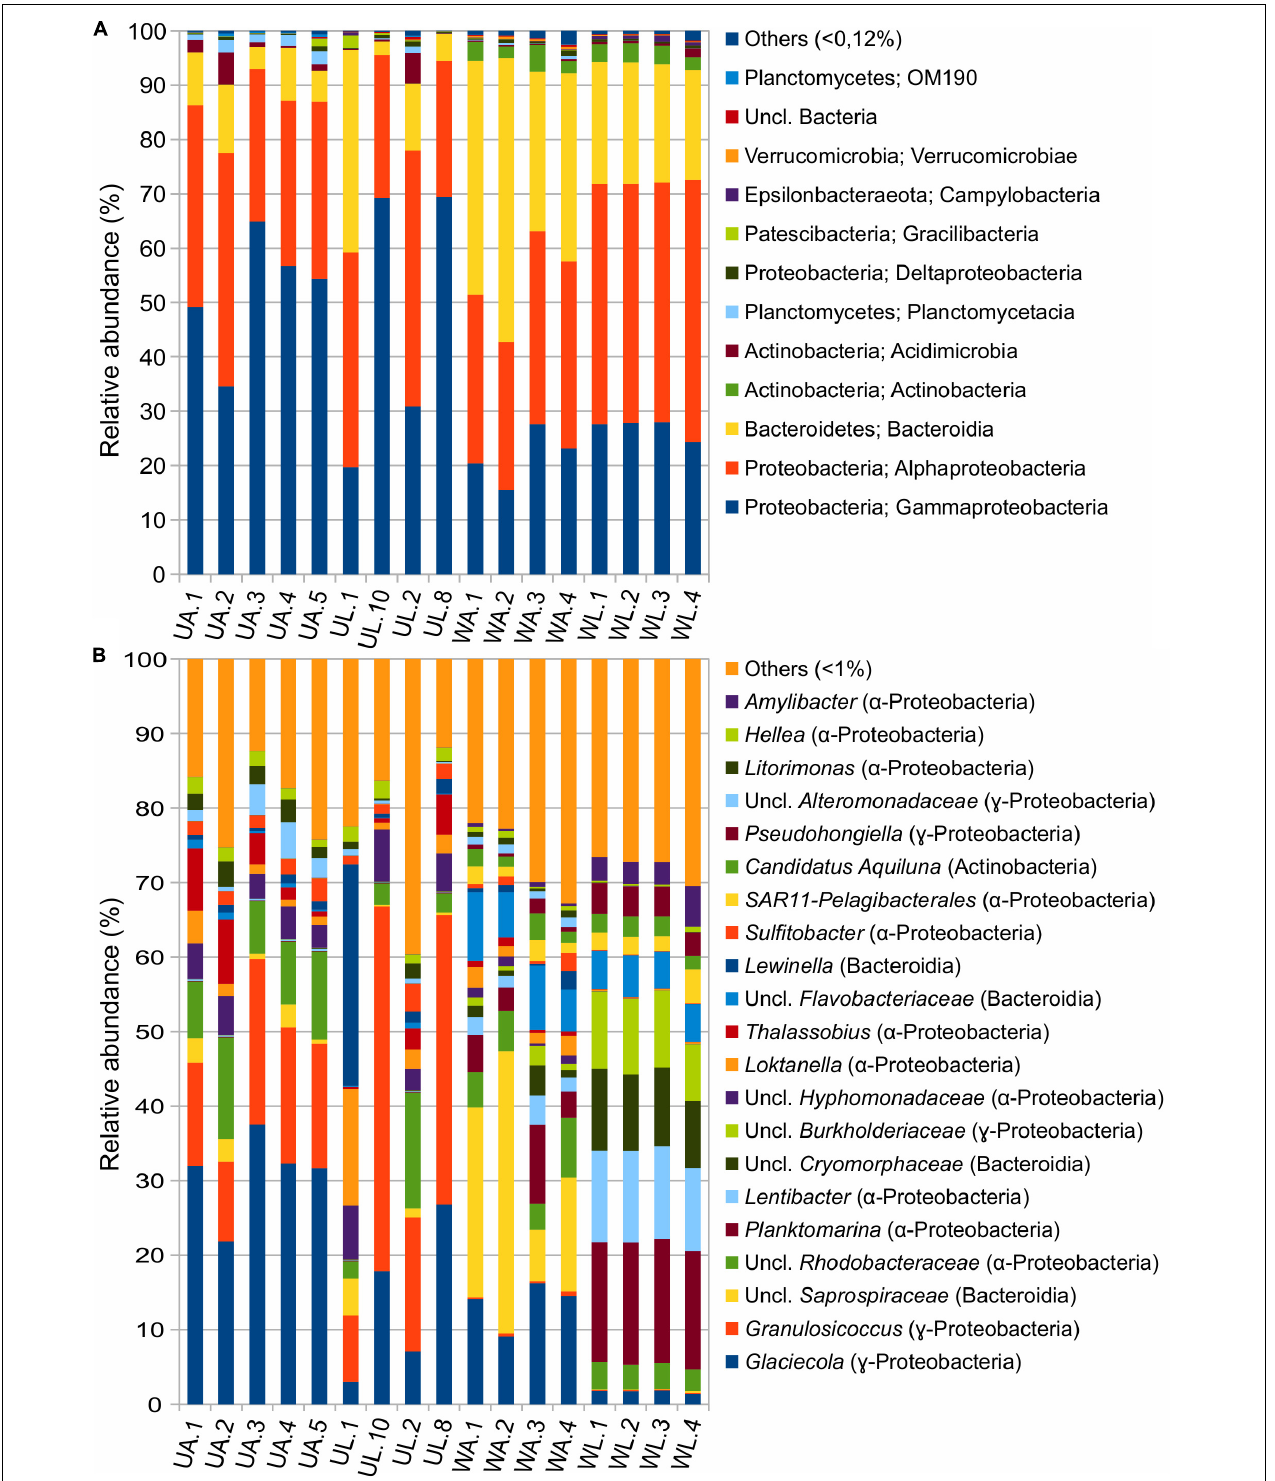
FIGURE 5 | Taxonomic composition of prokaryotic communities associated with Ulva (UA, Ulva from aquaculture; UL, Ulva from lagoon) and in seawater (WA, water from aquaculture; WL, water from lagoon) at (A) class and (B) genus levels.